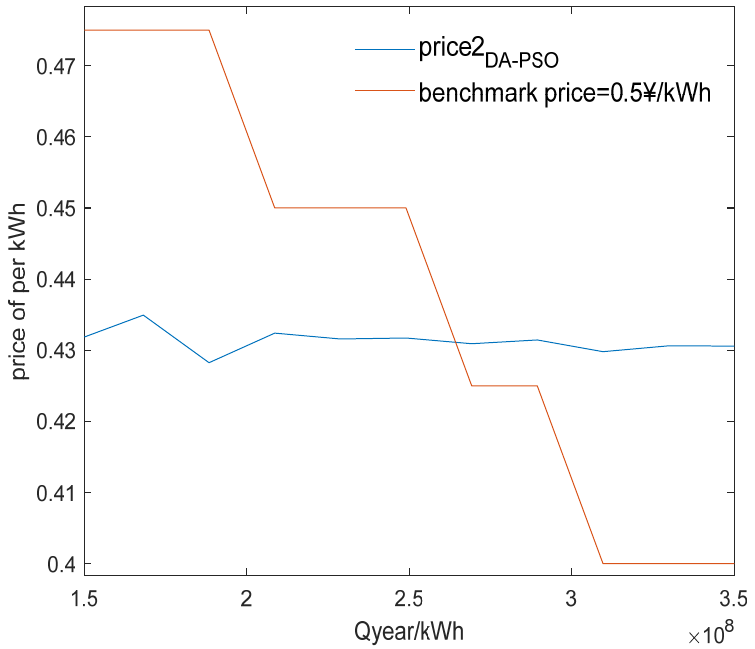
Figure 24. The relative relationship between the EKC of PSO decomposition based on Price2 and the long-term contract electricity price.